Question: Provide a one-line summary of what is displayed.
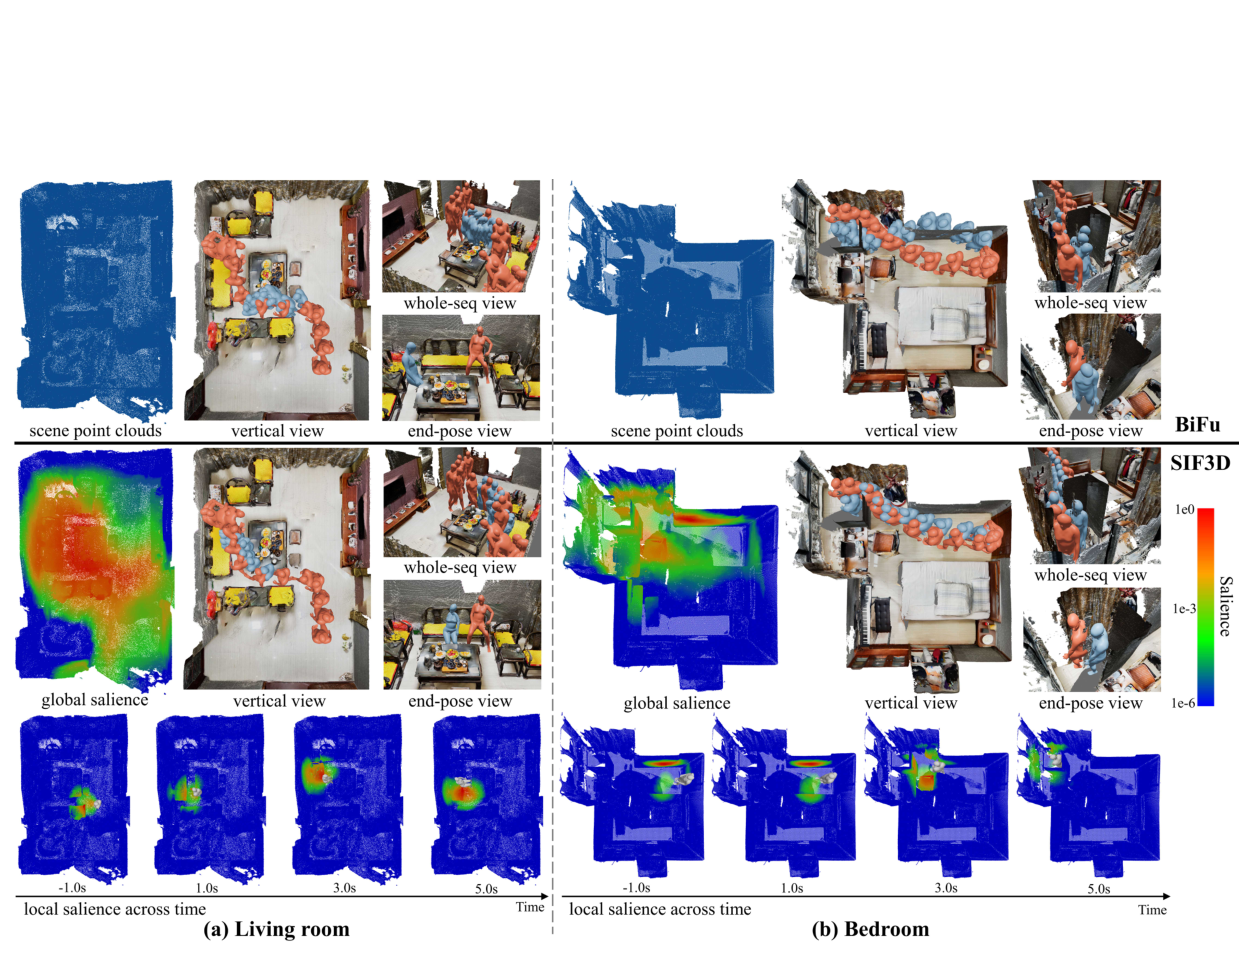
Answer: Visualizations of our SIF3D compared with the SoTA BiFu, under the scenarios of (a) living room and (b) bedroom. The top is the results of BiFu [73], which equally treats all scene points; in contrast, the middle row is our SIF3D, where the salient points are highlighted in red, and the underlying points are in blue. For the sake of clarity, the predicted sequence is presented from the vertical view, whole-seq view, and end-pose view. We note that the red human meshes are the ground truth, while the blue ones indicate the predictions. At the bottom, we present the local scene salience heatmap across time for SIF3D, with a time interval of 2 seconds.